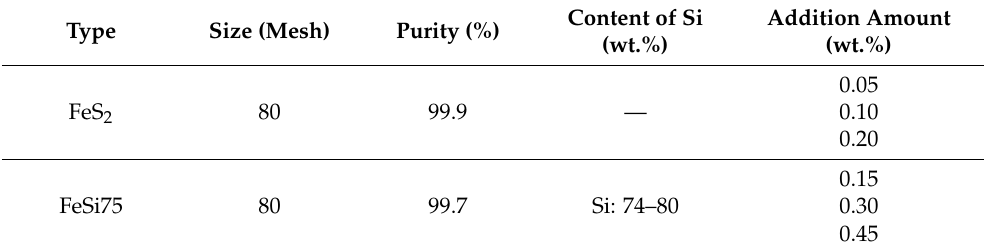
Table 2. Type and amount of additive in one chamber of double-chamber sample cup.